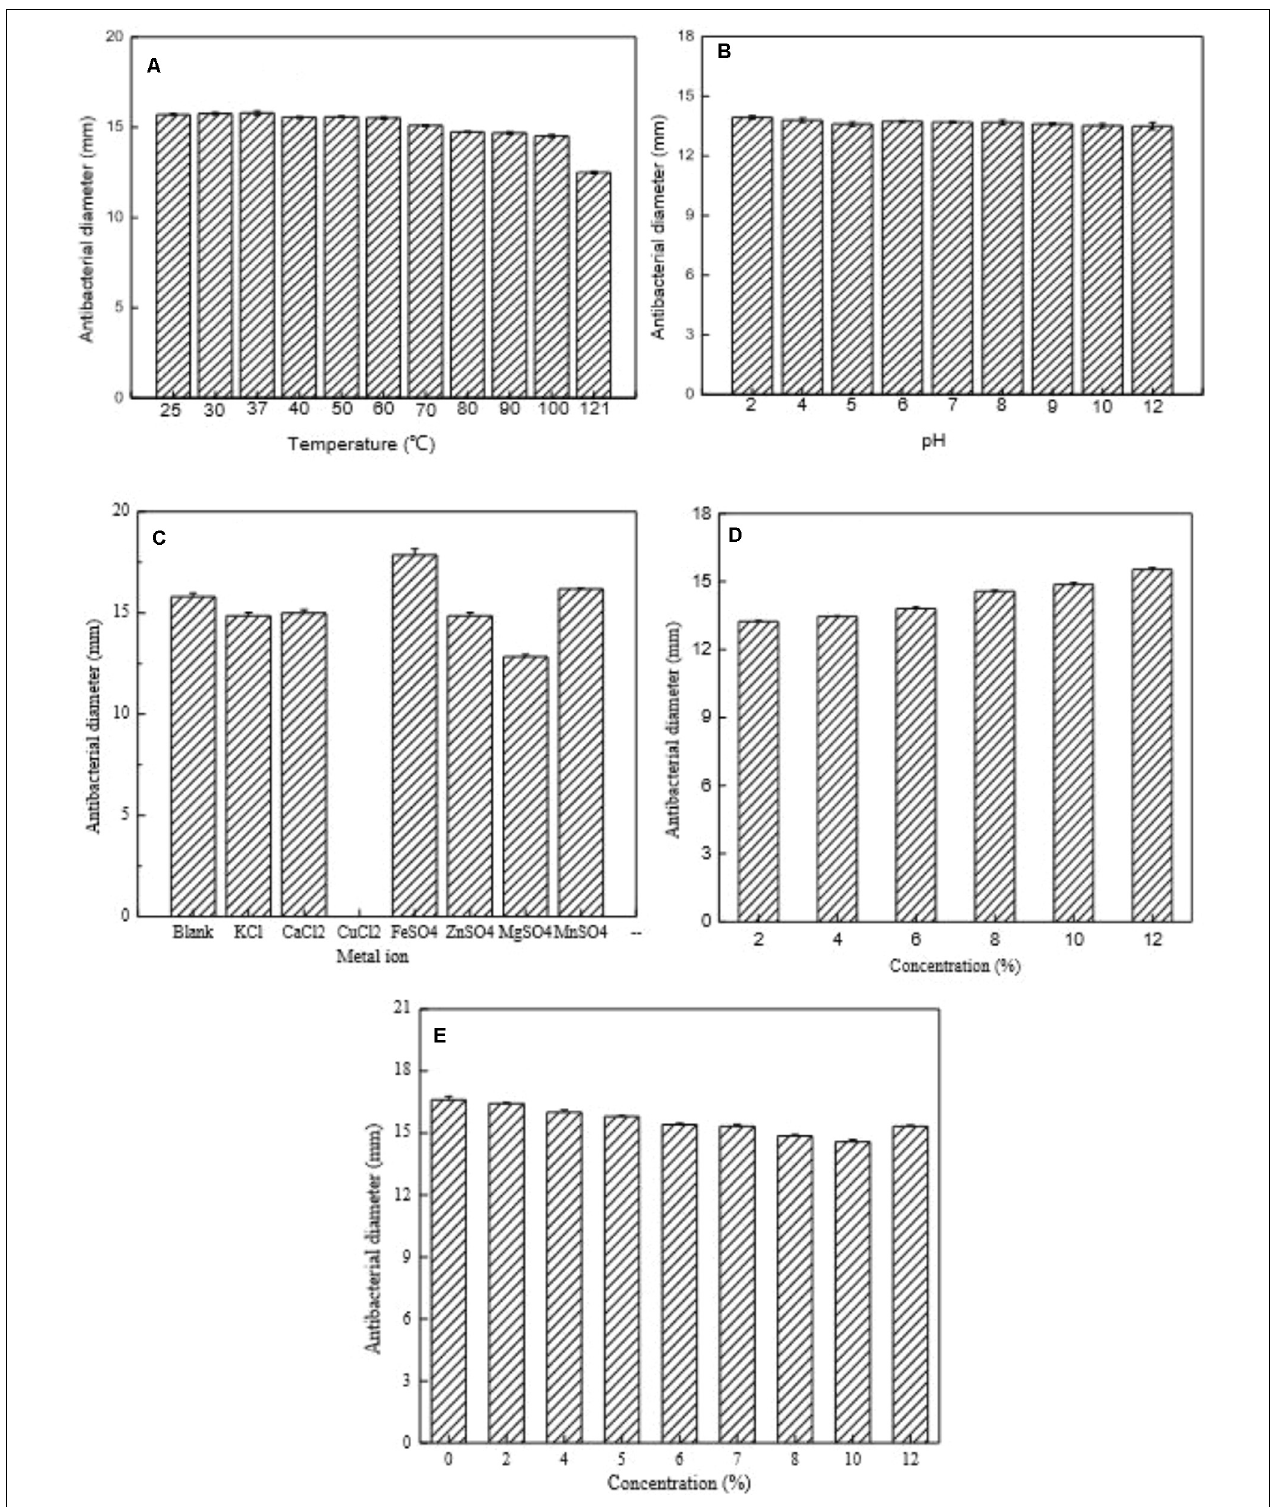
FIGURE 6 | Partial characterization of bacteriocin Lac-B23. (A) Effect of heat treatment; (B) Effect of pH; (C) Effect of metal ion; (D) Effect of ethyl alcohol; and (E) Effect of sodium chloride, on the antimicrobial activity.